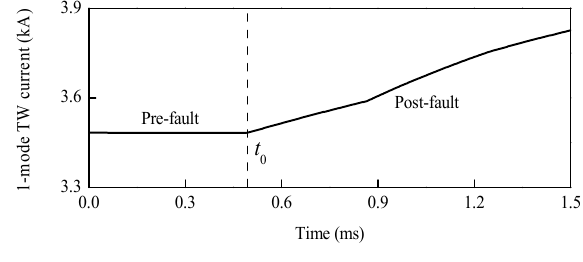
Figure 15. 1-mode TW current.